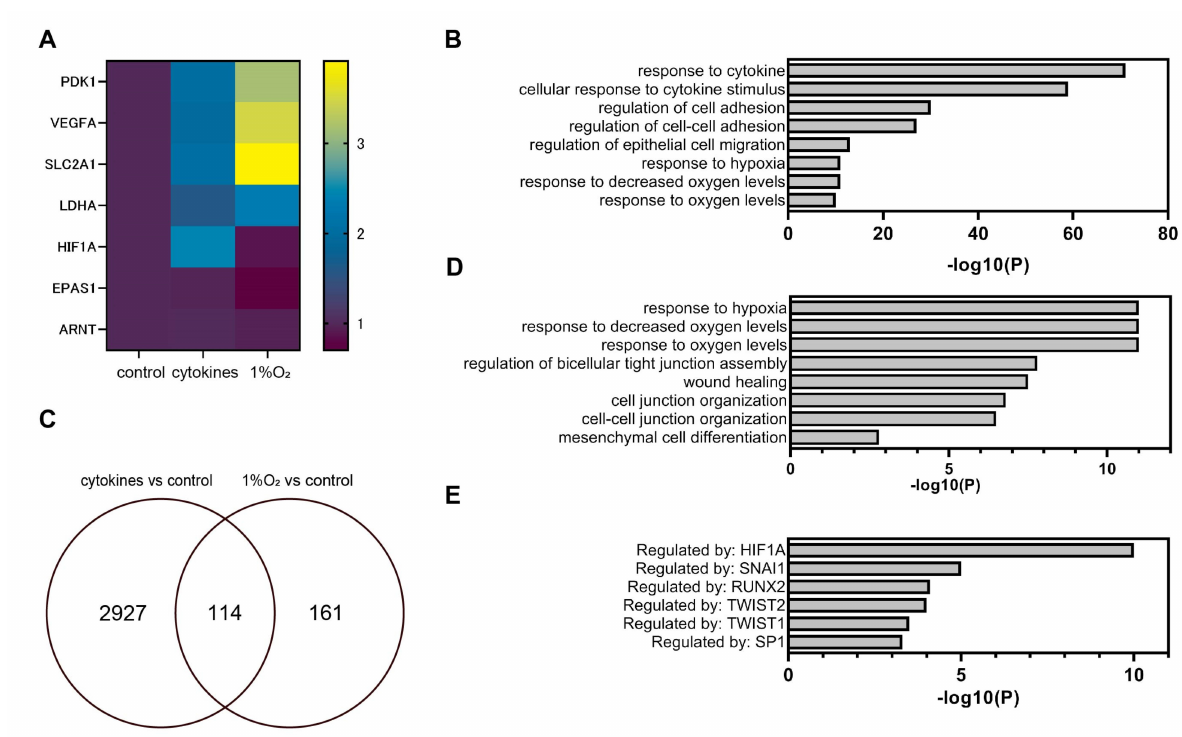
Figure 4. Global gene-expression analysis using RNA-Seq and next-generation sequencing (NGS). ( A – E ) EM-E6/E7/TERT cells were exposed to 1% O 2 or pro-inflammatory cytokines (500 ng/mL TNF α and 100 ng/mL IL-1 β ) under 20% O 2 conditions for 8 h, and total RNAs were analyzed by RNA-Seq. ( A ) Expression of genes regulated by HIF-1 and the expression of HIF1A , EPAS1 , and ARNT . ( B ) GSEA, with the gene sets whose expression ratios were significantly altered under pro- inflammatory cytokine exposure separated according to the gene ontology (GO) term. ( C ) Genes with significantly altered expression. ( D ) GSEA, with the gene sets whose expression was commonly upregulated by pro-inflammatory cytokine treatment and hypoxia exposure separated according to GO term. ( E ) Analysis using the TRRUST database of pathways commonly enriched by pro- inflammatory cytokine treatment and hypoxia